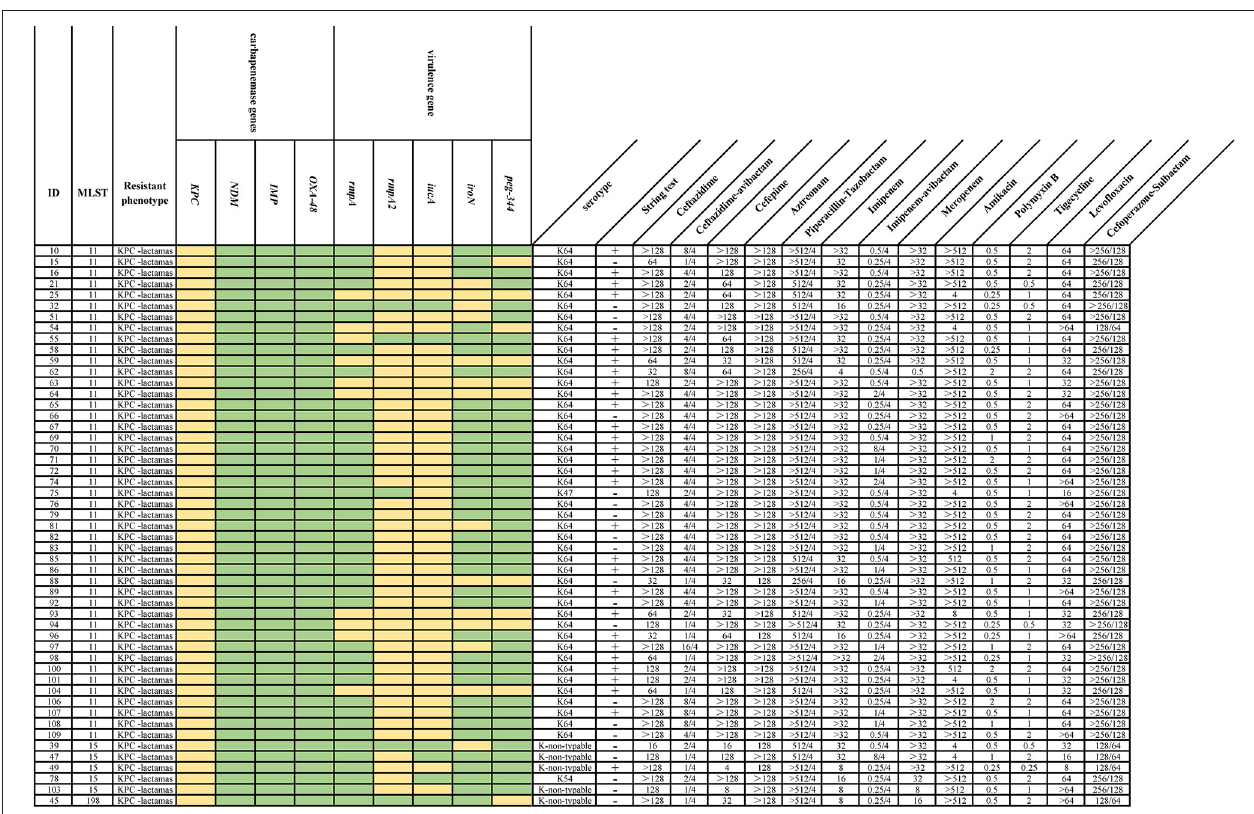
FIGURE 1 | MLST, resistance, and virulence factors, and MIC values of 51 CR-hvKP strains. Multilocus sequence type (MLST), resistance, and virulence factors and minimum inhibitory concentrations (MICs) are shown. The presence of genes in a specific genome is represented by the light yellow box and the absence of genes is represented by a green box. Each row of the heatmap (middle) indicates a strain, and each column represents a gene that belongs to the indicated functional clusters shown at the